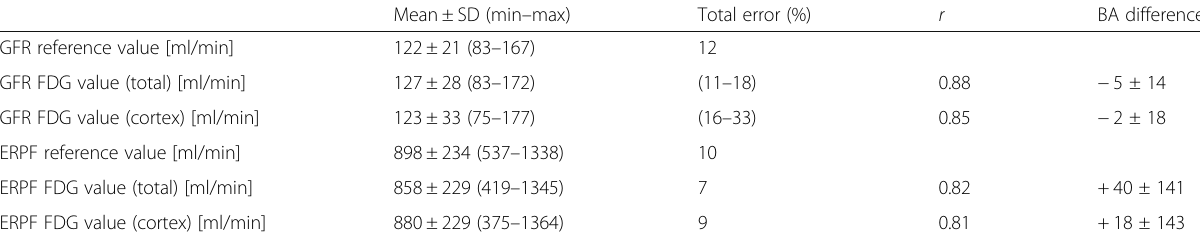
Table 2 Main results: mean values ± standard deviation (SD) as well as total errors for glomerular filtration rate (GFR) and effective renal plasma flow (ERPF)